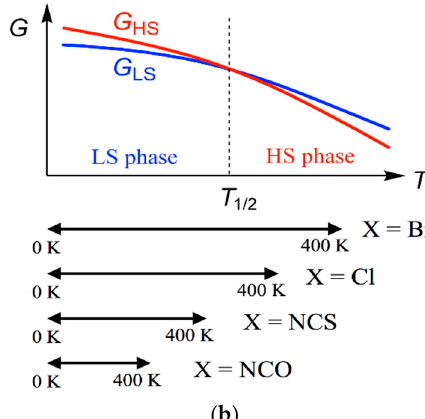
( d ) Figure 12. Optimized structures of 2p–3d–2p model compounds: [NiL’ 2 (NCO) 2 ] in the diamagnetic state ( a ) and the S total = 2 state ( b ) and [NiL’ 2 Cl 2 ] in the diamagnetic state ( c ) and the S total = 2 state ( d ), where L’ stands for methyl 2-pyridyl nitroxide. The Ni–O–N–C sp 2 torsion angles are indicated. Color codes: Ni, green; C, black; H, turquoise; N, blue; O, red; Cl, light green. Adapted from [122], published by MDPI, 2020.